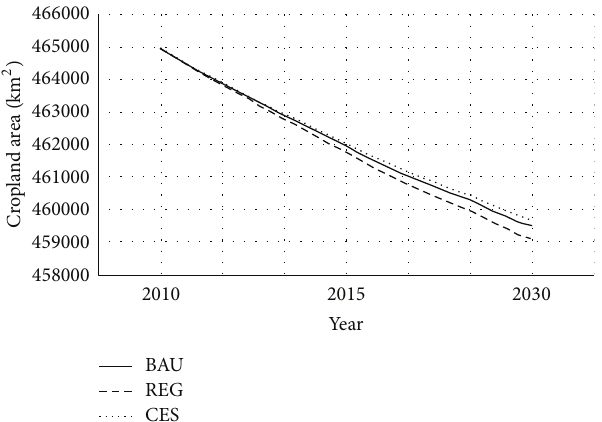
Figure 2: Changing trends of total cultivated land area in Northeast China during 2010–2030 under the three